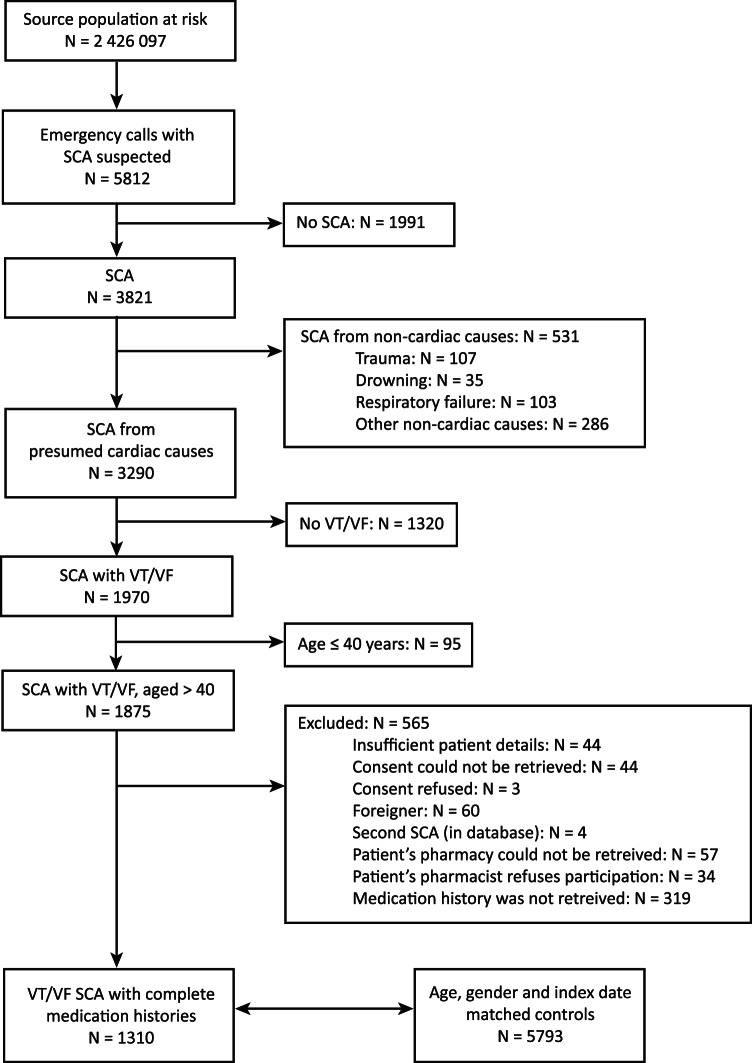
Flow chart.The source region had a population of 2 426 097 people in 2007 [Netherlands Statistics. http://statline.cbs.nl/. Accessed May 15, 2010].